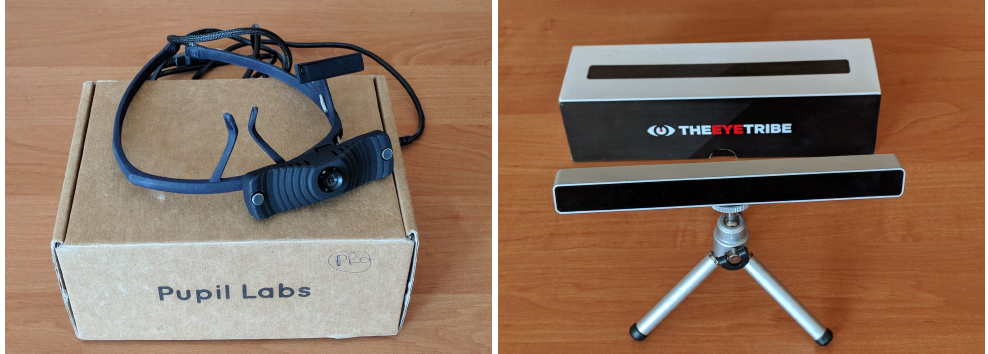
Figure 6. Eye trackers used during the experimental part of the research. Left: Pupil Labs headset eye tracker, right: The Eye Tribe remote eye tracker to be mounted below a